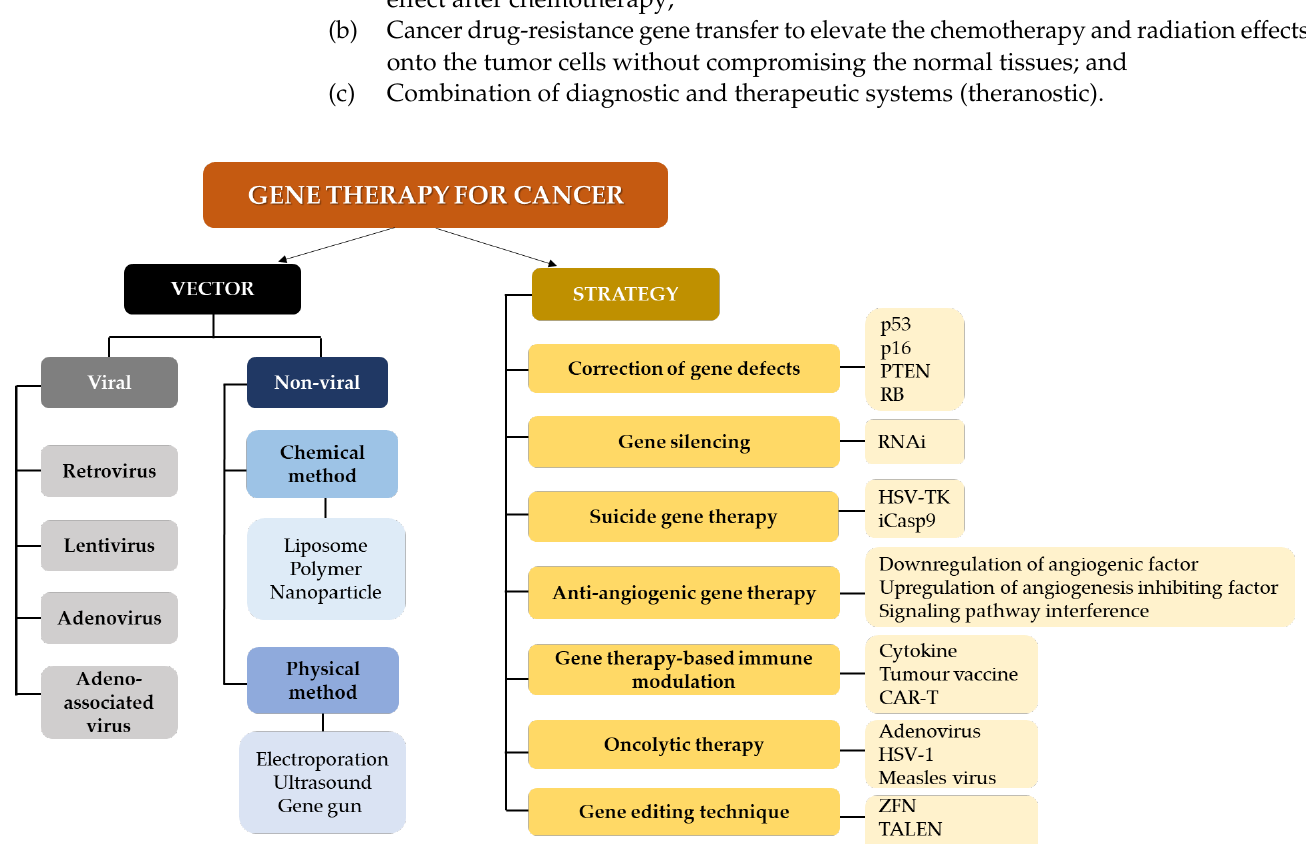
Figure 2. Gene therapy approaches and vectors for cancer treatment. Methods for gene therapy in cancer include RNA interference (RNAi), herpes simplex virus thymidine kinase (HSV-TK), inducible caspase 9; CAR-T (iCasp9): chimeric antigen receptor T-cell therapy (CAR-T), herpes simplex virus 1 (HSV-1); zinc finger nucleases (ZFN), transcription activator-like effector nucleases (TALEN) and clustered regularly interspaced short palindromic repeats-Cas9 (CRISPR-Cas9).